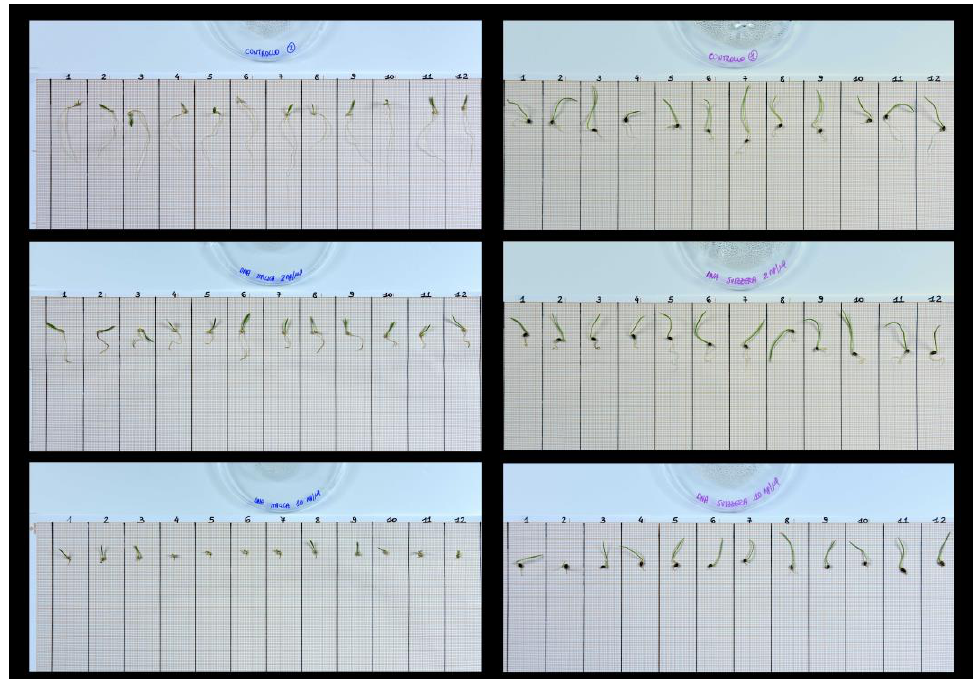
Figure 3. Examples of photographs of the seedlings from selected Petri dishes moved onto graph paper. Images refer to seedlings of S. italica ( left ) and S. pumila ( right ), unexposed ( top ) or exposed to self-DNA solutions, at lower ( center ) and higher ( bottom ) concentration.